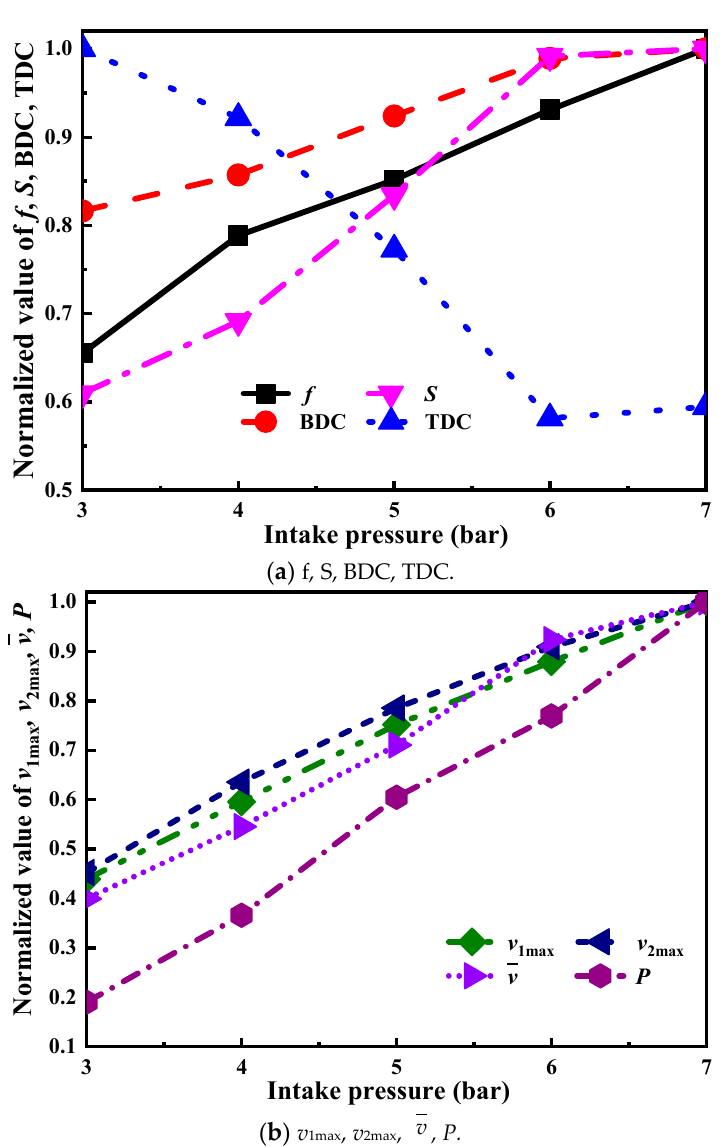
Figure 14. Variation of performance parameters with intake pressure.